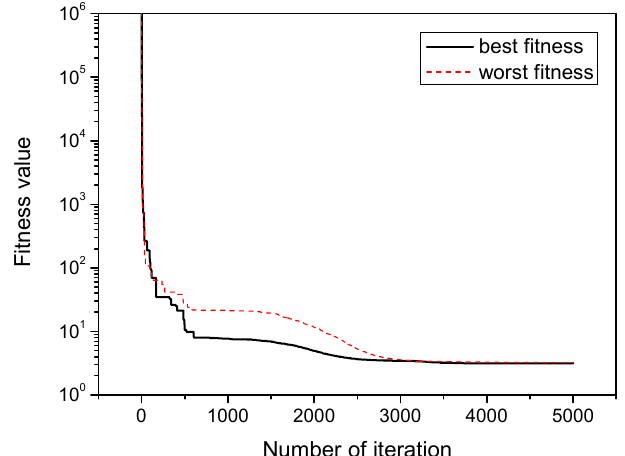
Figure 11. Convergence of the fitness